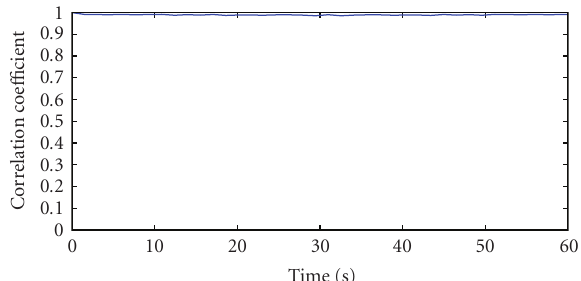
Figure 2: Correlation coe ffi cients as a function of time in measured